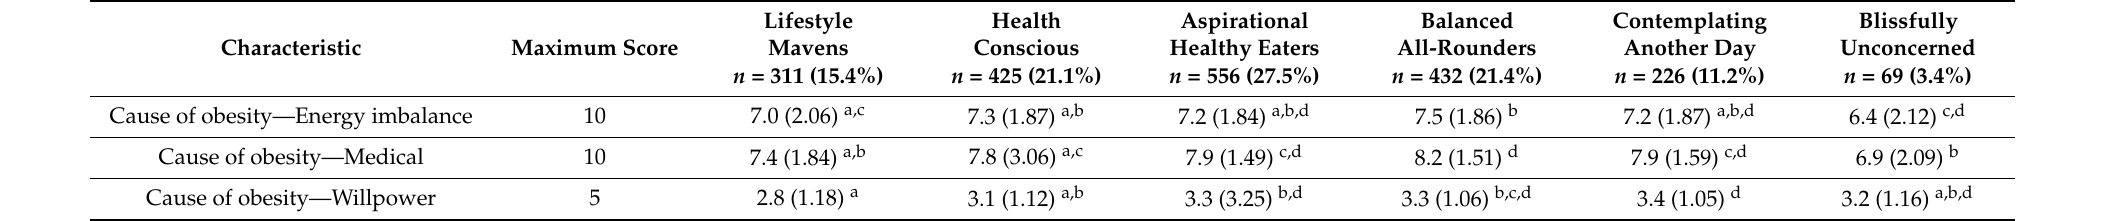
Table 2. Perceived causes of obesity by Living and Eating Health Segments (LEHS) ( n = 2019).